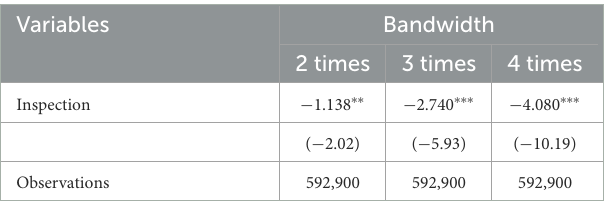
TABLE 5 Results of bandwidth sensitivity.